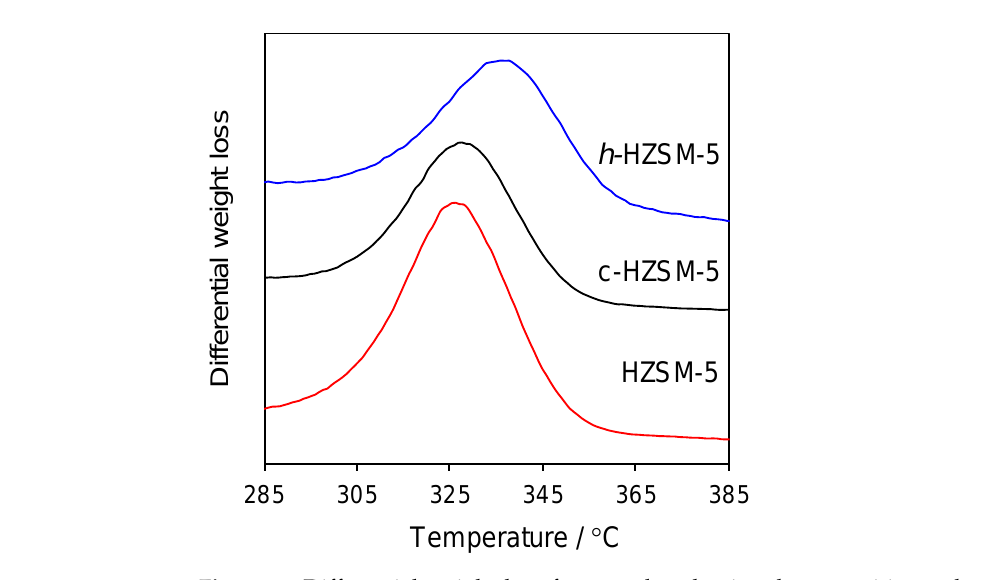
Figure 5. Differential weight loss from sec-butylamine decomposition to butene and NH 3 over h-HZSM-5, c-HZSM-5, and HZSM-5.